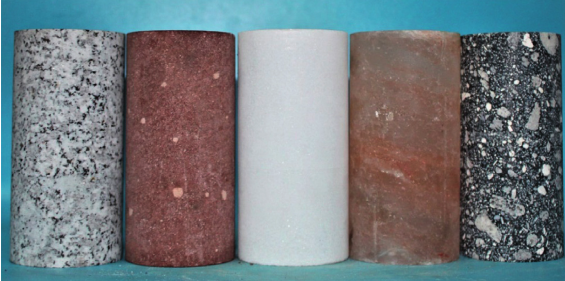
Figure 4: Main types of standard specimens.